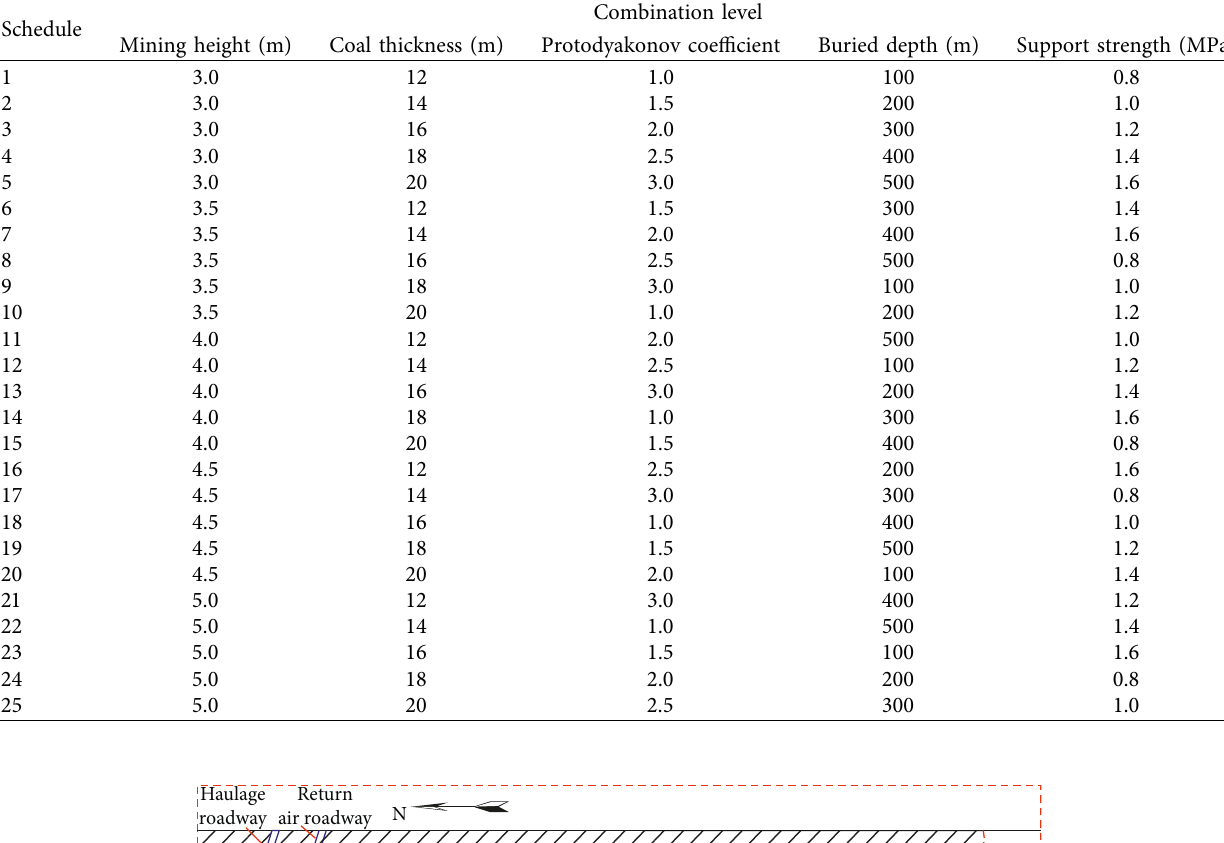
Table 1: Orthogonal test scheme.